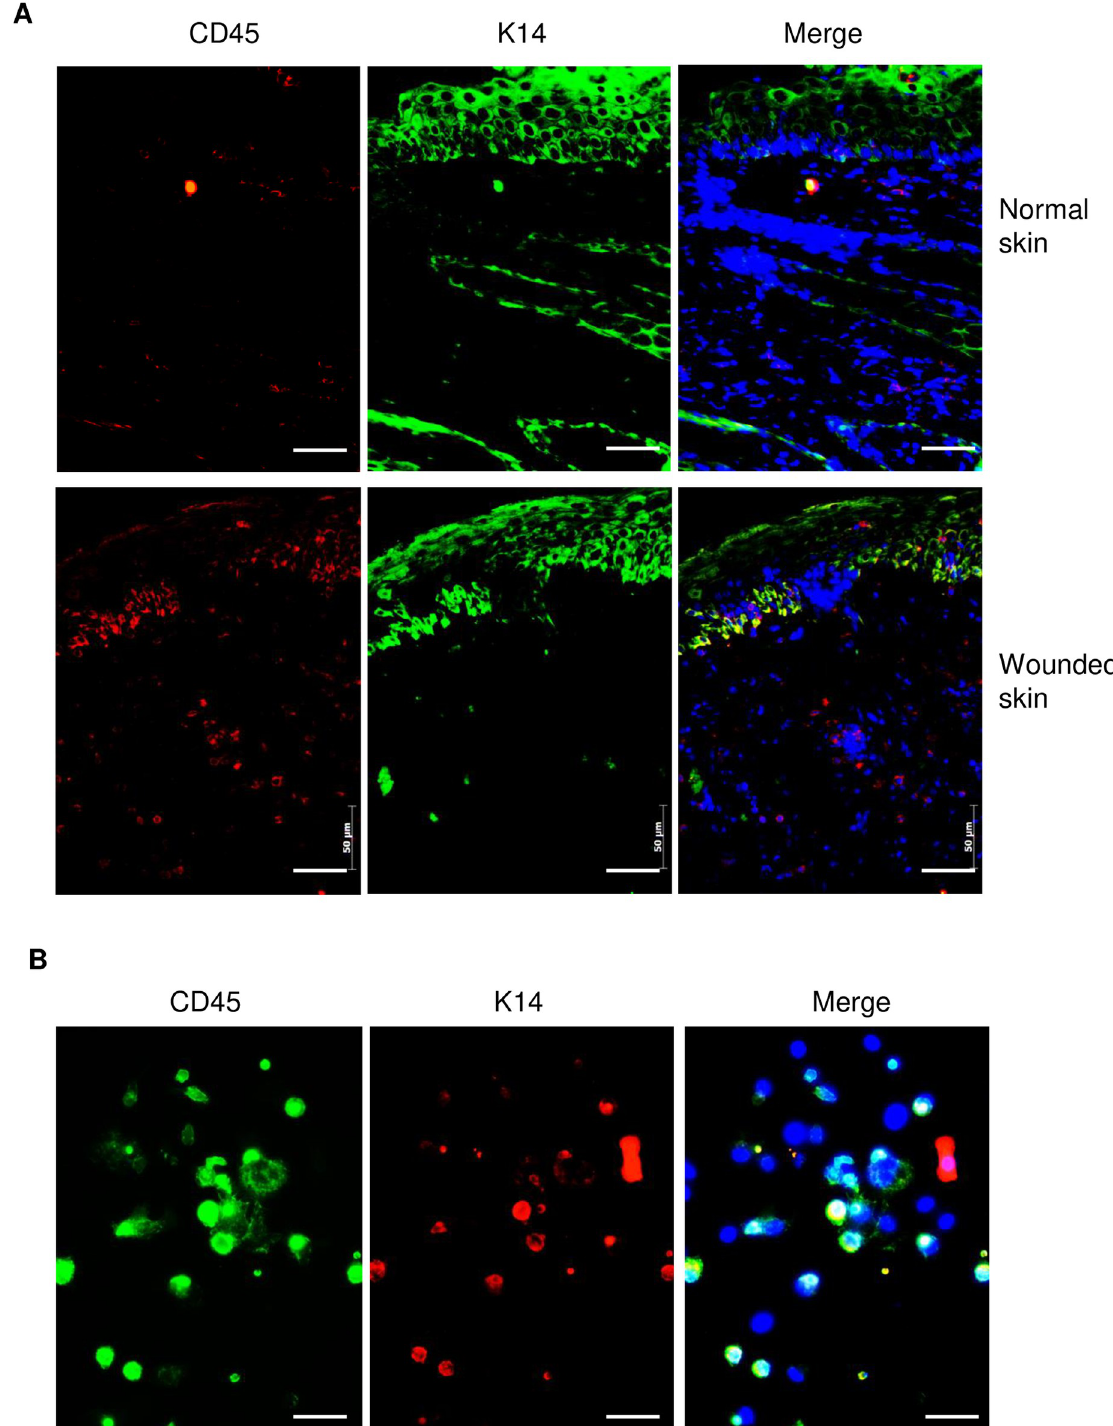
Fig 2. Conversion of CD45-positive hematopoietic cells to keratinocytes in re-epithelialization skin of mice. ( A ) Double immunofluorescent staining with keratin-14 (K14) and CD45 antibodies in normal skin (Top panels) and wounded skin (Bottom panels) of Balb/C mice. Wounded skin was taken from mice with 8 mm punch biopsy of excisional wounds after wounding for 14 days. ( B ) Double immunofluorescent staining with K14 and CD45 antibodies in cultured skin cells isolated from wound edge of Balb/C mouse skin. Skin cells were isolated from the edge of wounded skin of mice by collagenase digestion. Cells were cultured for 48 hours before fixation and performing an immunofluorescent staining. DAPI (blue) was used as a nuclear counterstain. Scale bars in all images was 50 μ m. https://doi.org/10.1371/journal.pone.0262060.g002 PLOS ONE | https://doi.org/10.1371/journal.pone.0262060 June 23,